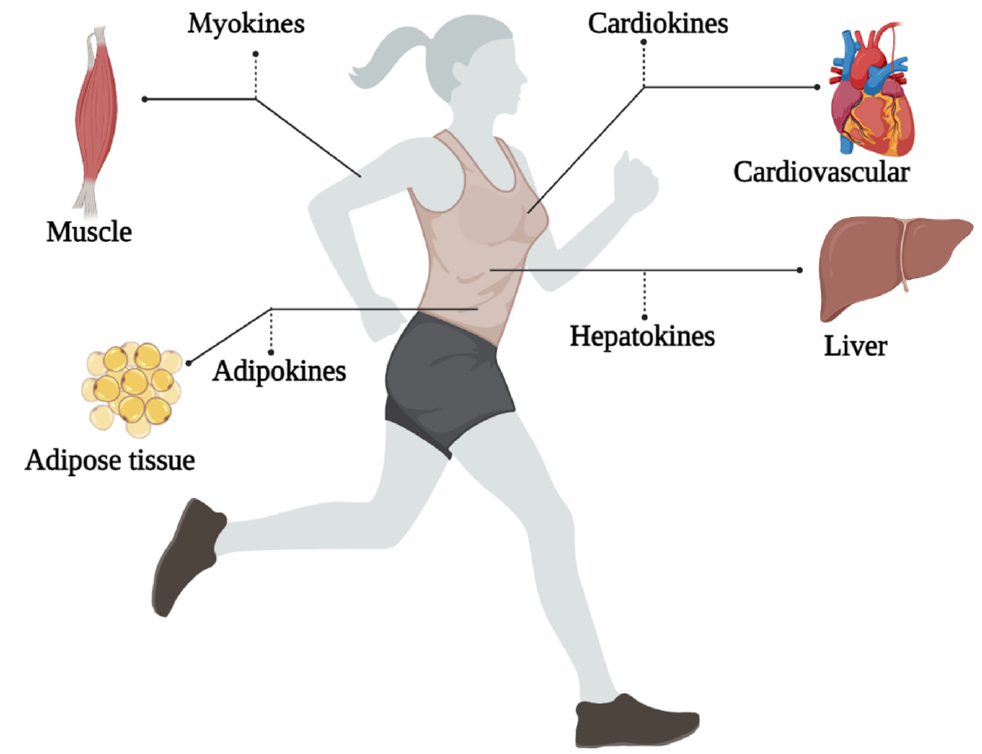
Figure 1. An overview of the exerkines investigated in this study. By reviewing past studies related to rehabilitation and physical exercise in the sur- vivors of COVID-19, it can be well understood that most of those who were infected with COVID-19 were overweight and obese (Figure 2) [37–56]. Obesity could affect the exerkine response to physical exercise, especially in women. Now that new strains of COVID-19 are on the way and obese women are experiencing a high severity of the disease, this study discusses the associations between gender, physical exercise, and exerkine